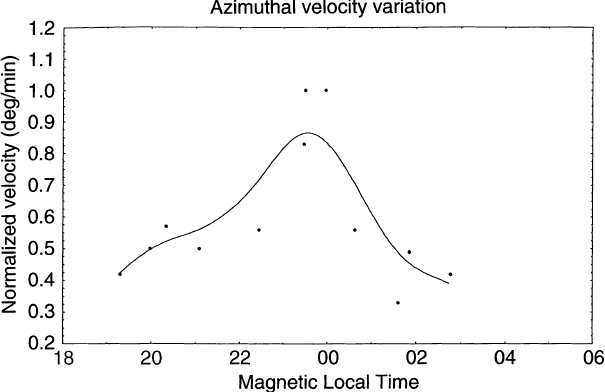
Fig. 11. The variation of the longitudinal expansion velocity of the substorm current wedge versus magnetic local time. A distance weighted least squares fit is overplotted to show the general trend of our